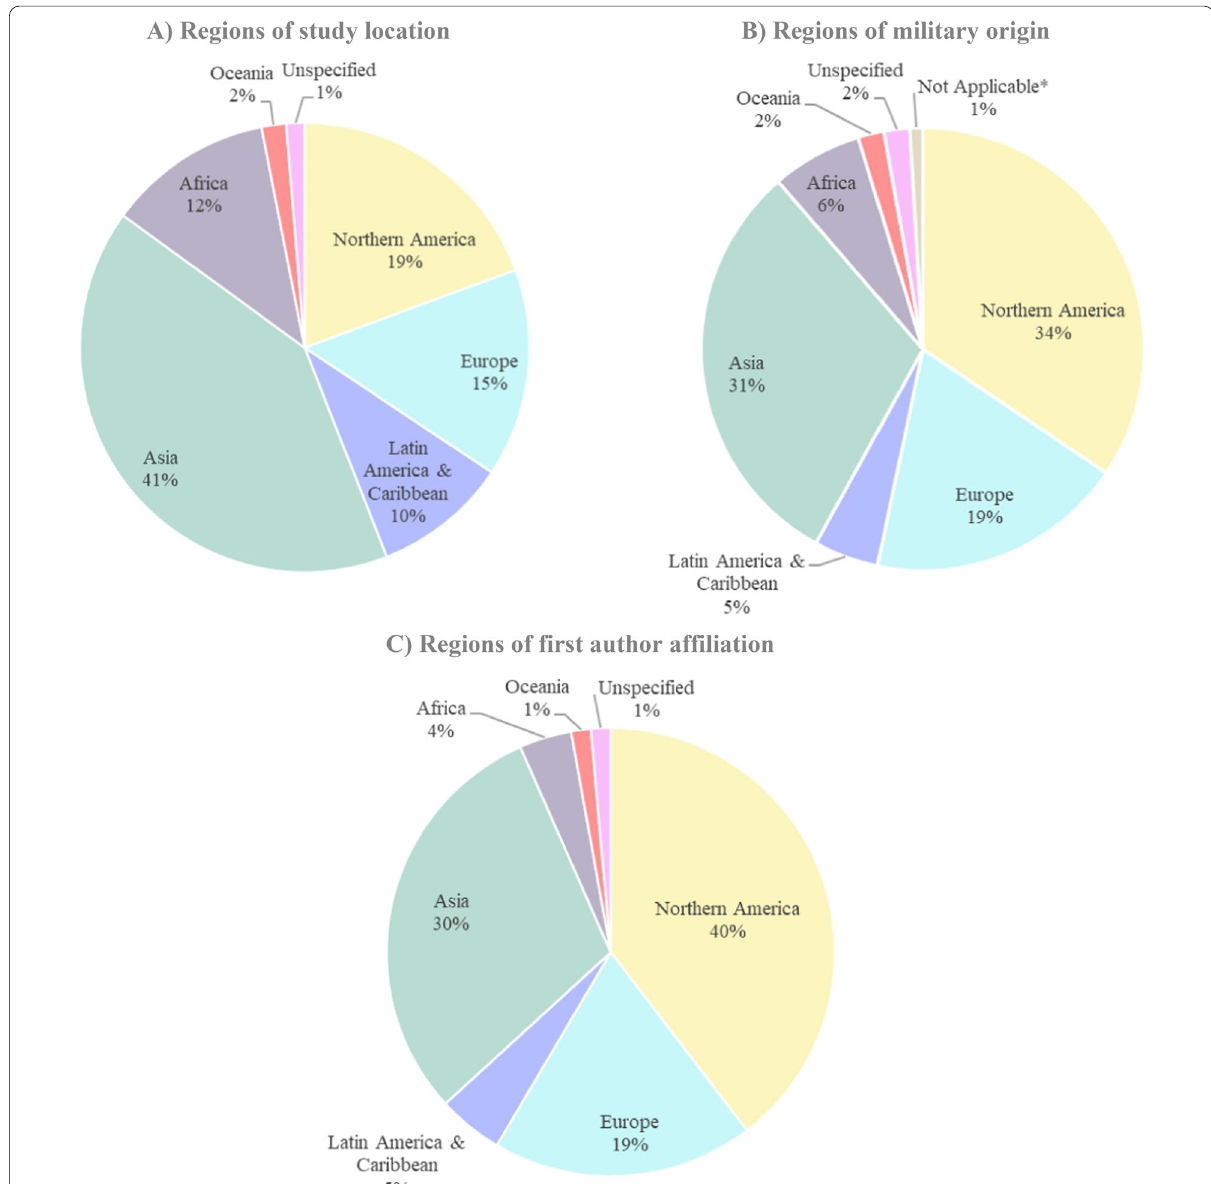
Fig. 2 Pie charts showing region-level data pertaining to the studies included in the analysis. We grouped countries into 6 regions: Northern America, Latin America & Caribbean, Asia, Europe, Africa, and Oceania, based on the United Nations geoscheme system. Please see Additional file 1: Table S3 in our supplementary materials for the specific list of countries included within each region. Pie chart ( A ) depicts the percent of studies taking place in each of the 6 regions. Pie chart ( B ) depicts the percent of studies with military groups originating from each of the 6 regions. Pie chart ( C ) depicts the percent of studies whose first author is affiliated with each of the 6 regions. Some articles took place in multiple regions, studied military groups originating from multiple regions, and/or the first author had multiple affiliations. * Not applicable refers to articles which did not include the military among their study